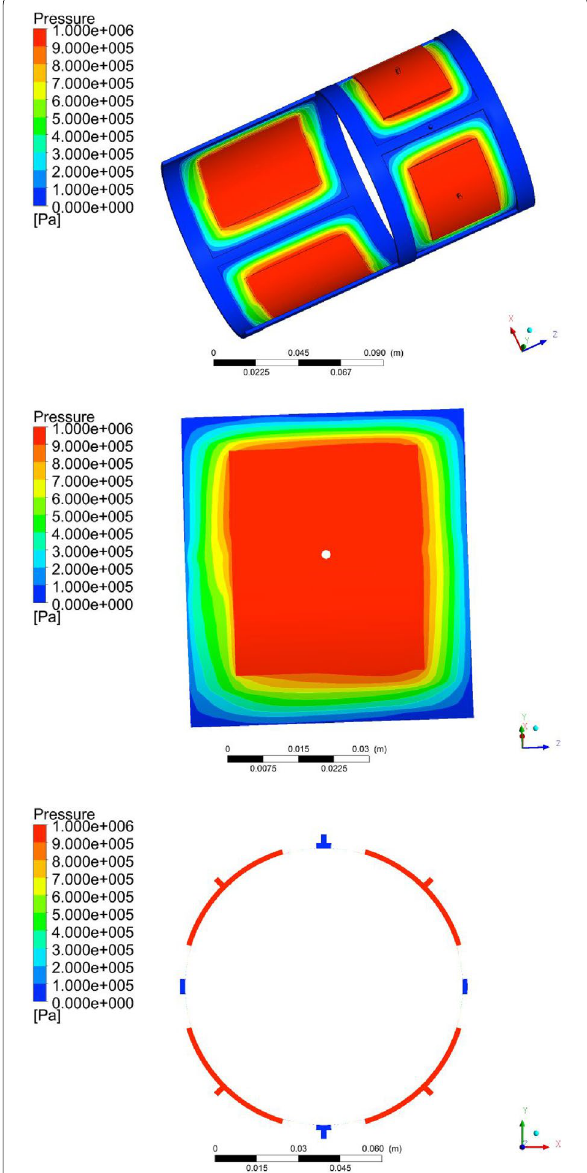
Figure 15 Oil film pressure cloud diagram under a partial load Figure 14 Oil film pressure cloud diagram without a partial